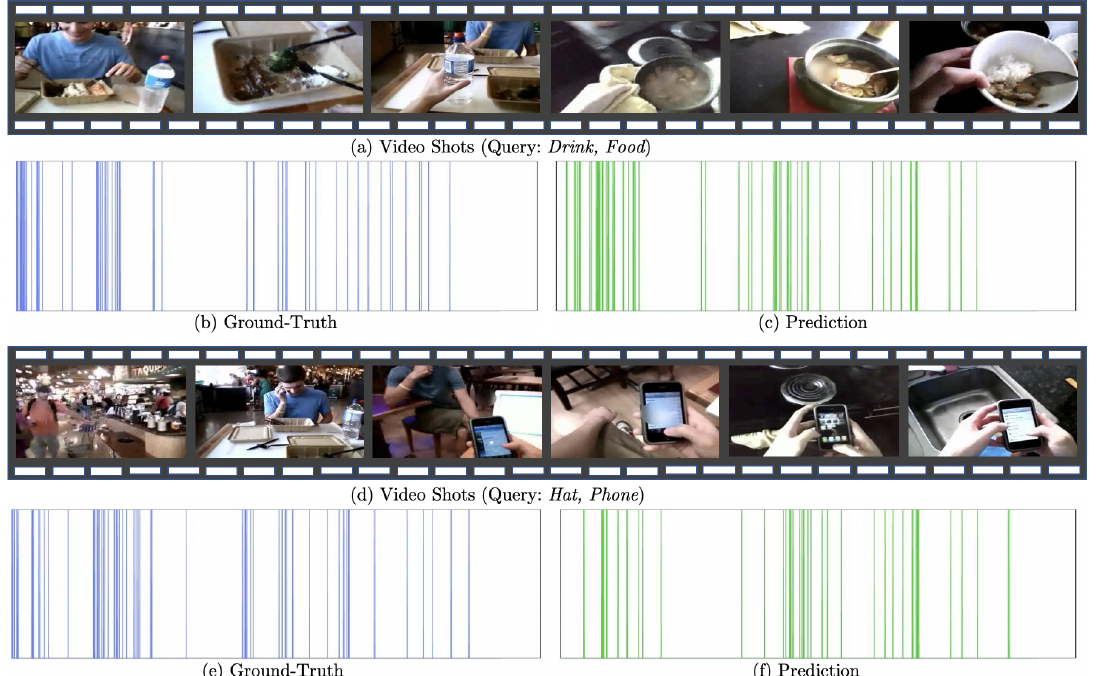
Figure 5. Visualization results of our proposed method given the query { Drink , Food } , and { Hat , Phone } for Video1. ( a , d ) are several video shots samples. ( b , e ) and ( c , f ) show the ground-truths and the predicted summaries, respectively. The x − axis is the shot number, and the blue/green lines represent the selected video shots in the